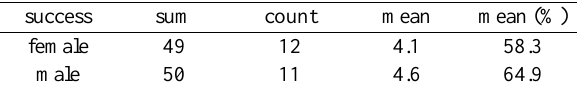
Table 3 Success of the students in dependency on